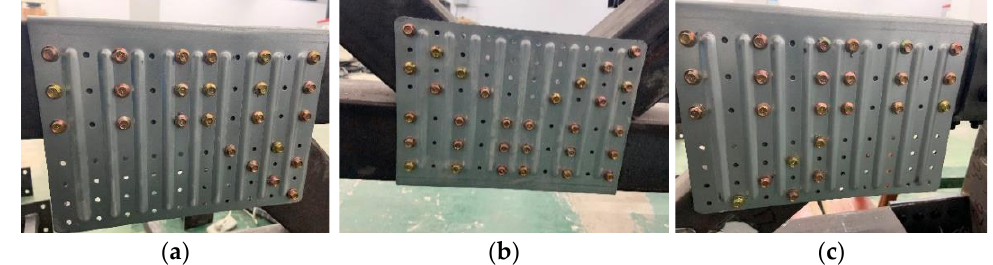
Figure 5. Connection details between the U connectors and the truss-beam members for specimens named JU100.( a ) Node at free end of the beam, ( b ) node in the middle, ( c ) node adjacent to the column.